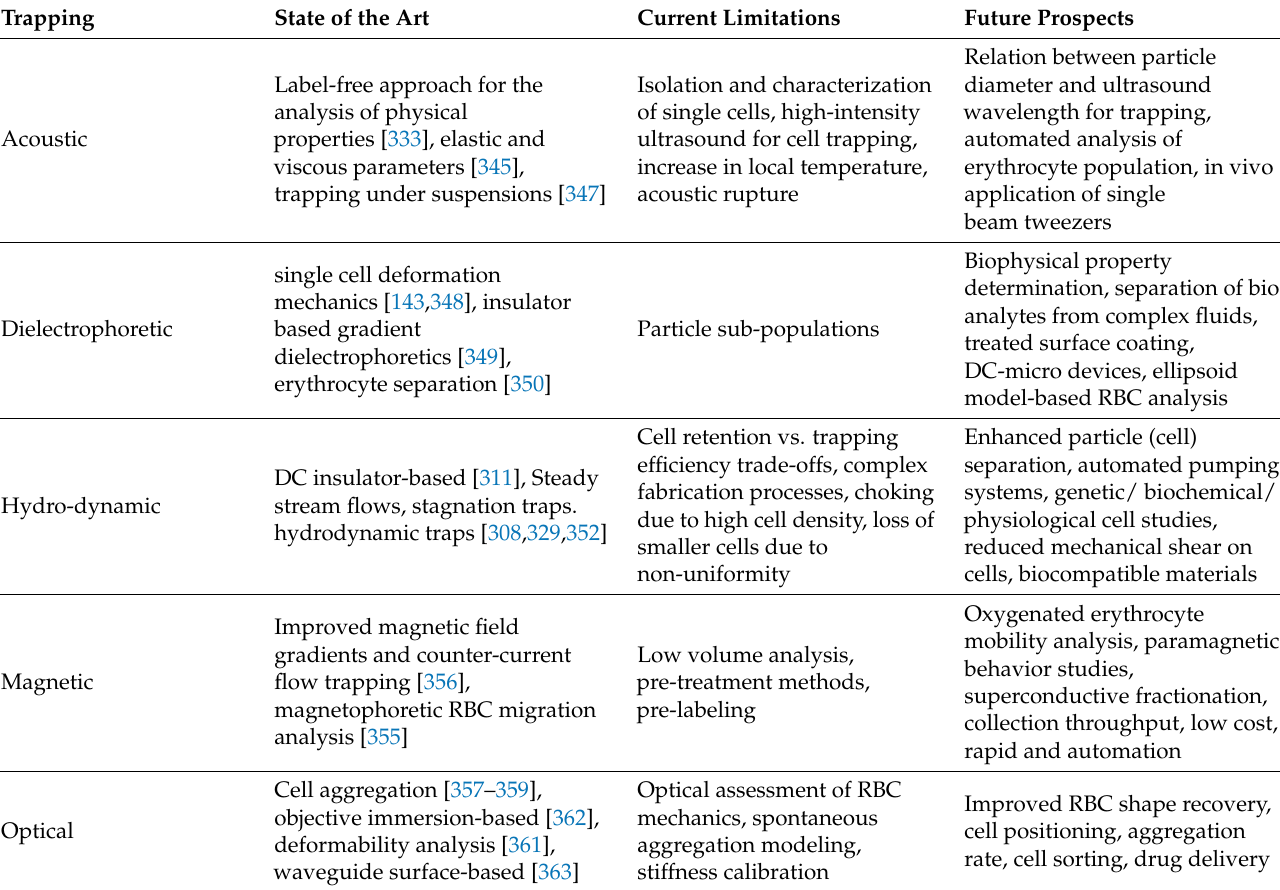
Table 5. Single RBC trapping